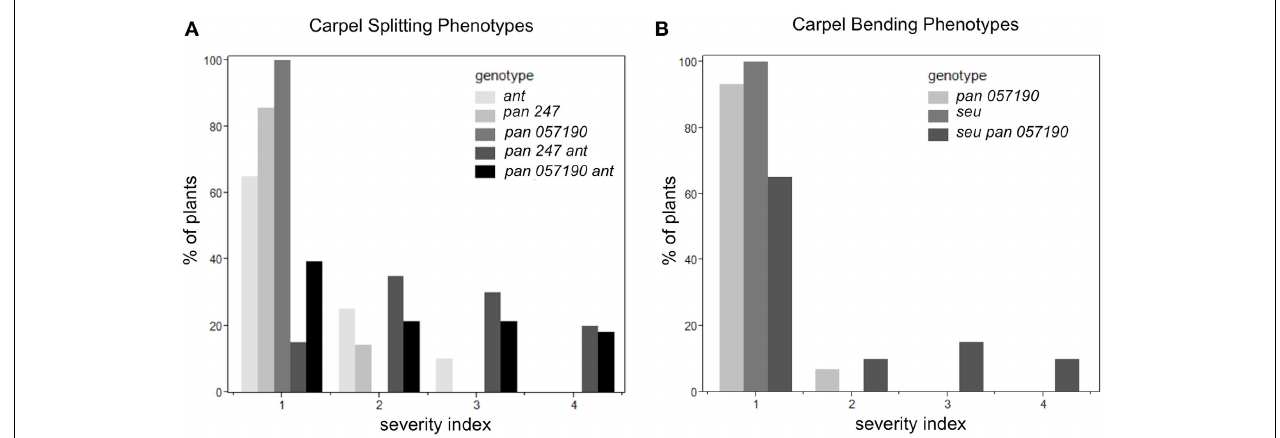
FIGURE 3 | Enhanced severity of carpel splitting in pan ant and carpel bending in seu pan double mutants under long-day growth conditions. (A) The pan ant double mutants showed a statistically more severe carpel splitting than the single mutant parents. (B) seu pan double mutant plants showed statistically more severe carpel bending than the single mutant